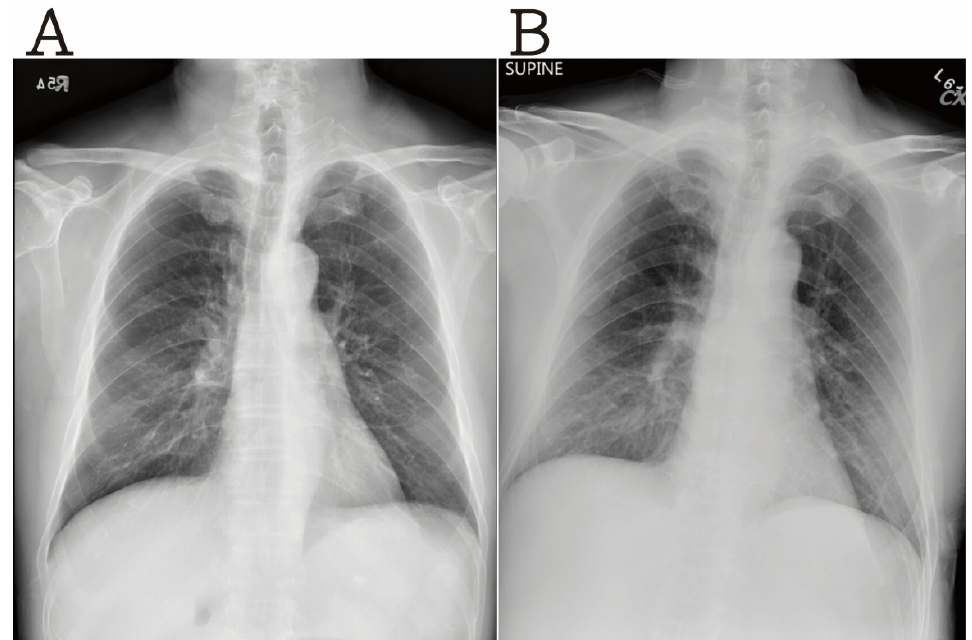
Figure 1. The chest X-ray revealed mild increased bilateral lung markings without a significant pneumonia patch (A) initially (B) after one day. pneumonia patch ( A ) initially ( B ) after one